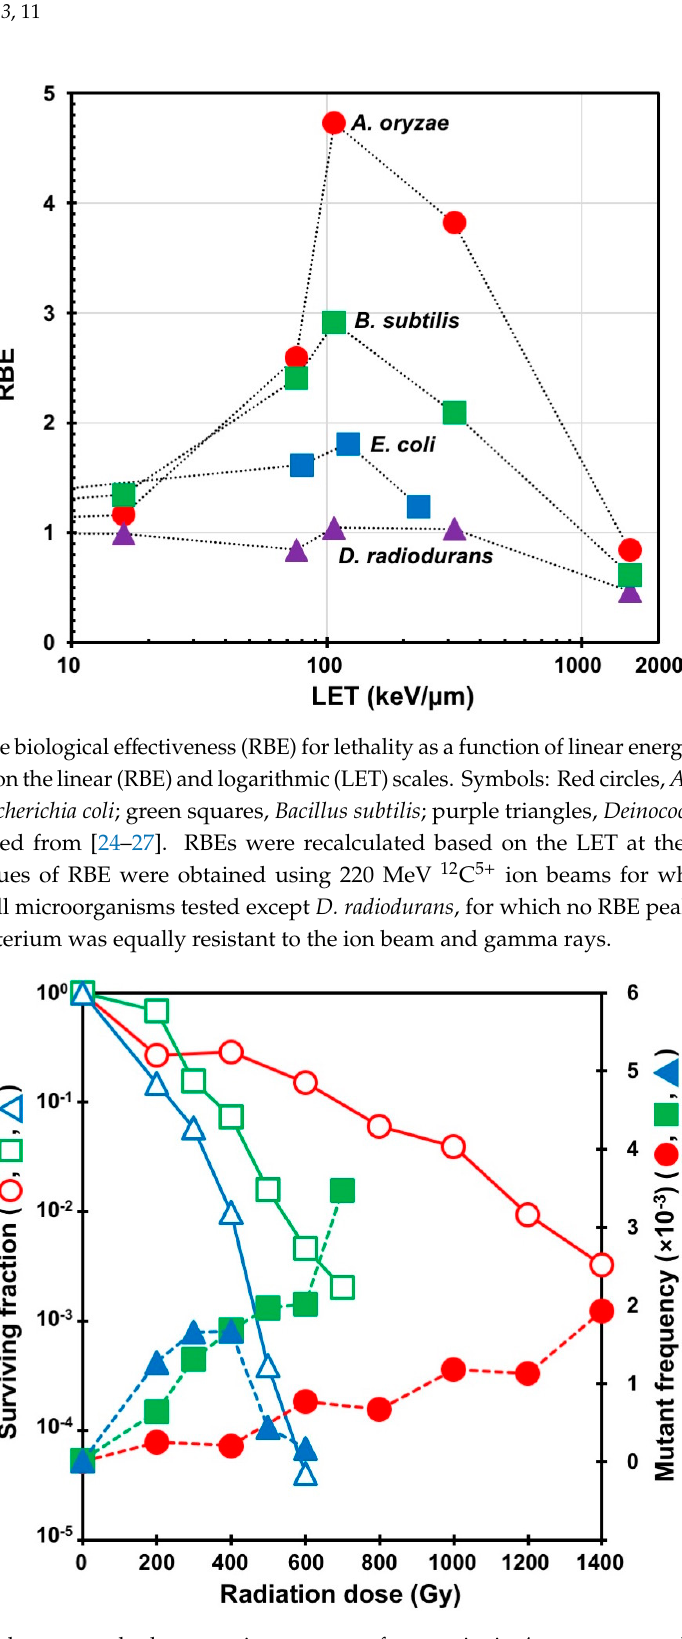
Figure 3. Survival curves and selenate-resistant mutant frequencies in A. oryzae exposed to gamma rays and carbon ion beams. Open and closed symbols indicate surviving fraction and mutant frequency, respectively. Symbols: Circles, gamma rays; squares, 12 C 6 + ion beams; triangles, 12 C 5 + ion beams. Data are modified from Toyoshima et al. (2012) [24]. The highest values of mutant frequency were obtained at a radiation dose giving a surviving fraction of around 0.1% to 1%.